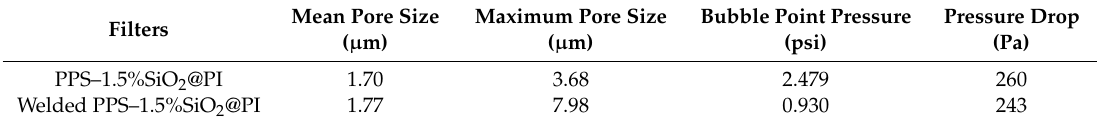
Table 1. Characteristics of PPS–1.5%SiO 2 @PI filters before and after being welded by solvent vapor.